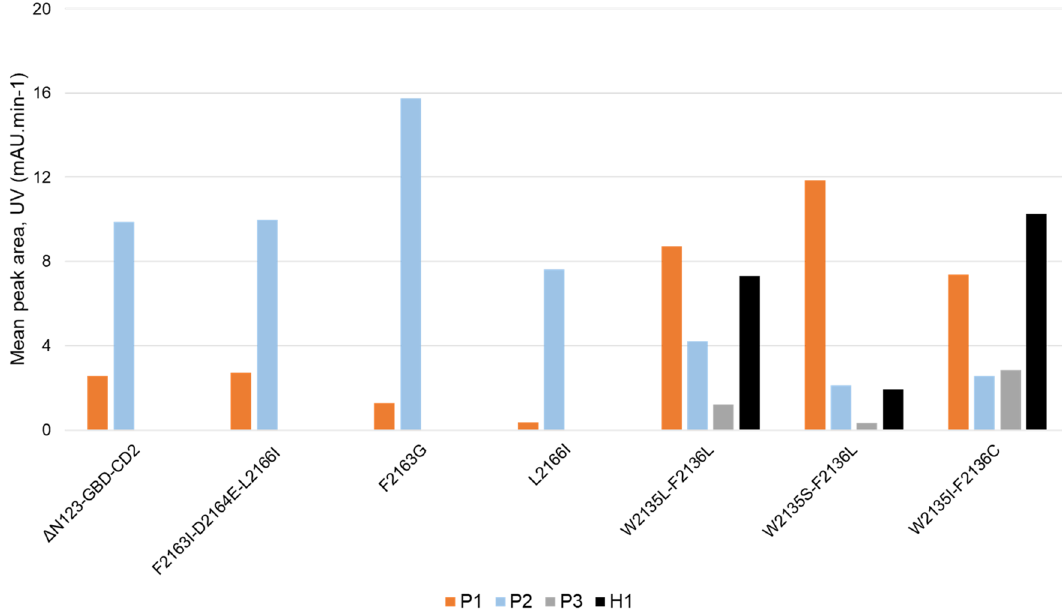
Figure 3. Distribution of products formed by ΔN 123 -GBD-CD2 branching sucrase and the six selected mutants (F2136I-D2164E-L2166I, F2163G, L2166I, W2135L-F2136L, W2135S-F2136L and W2135I-F2136C). The bar plot gives the amount of pentasaccharides [ P1 (orange), P2 (cyan), P3 (gray)] and the hexasaccharide ( H1 black) as detected by HPLC–UV (wavelength at 220 nm). Reactions were performed in the presence of 1 M sucrose and 50 mM tetrasaccharide ABC ′ D ′ , for 16 h using 1 U mL −1 enzymes at pH 5.1 and 30 °C.